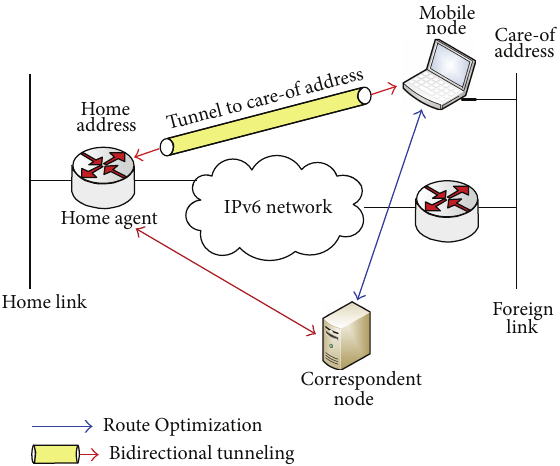
Figure1:MobileIPv6bidirectionaltunnellingandRouteOptimiza-